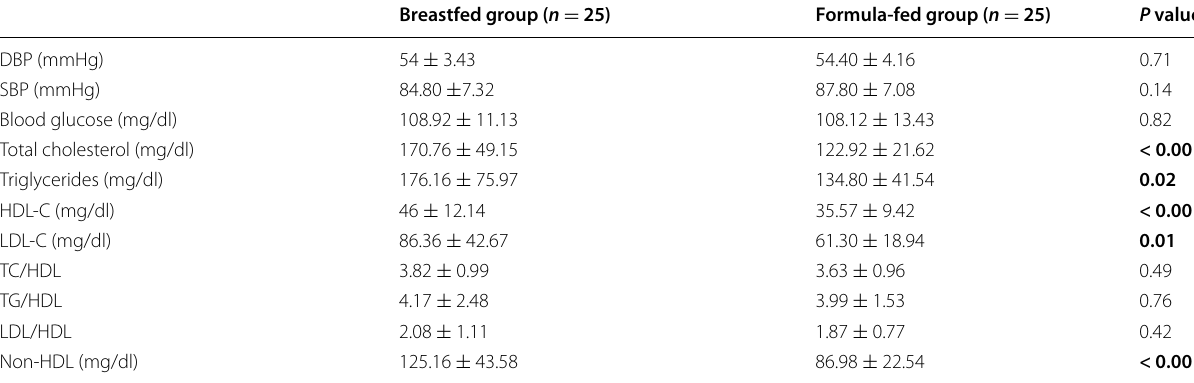
Data expressed mean (SD). Student t‑test was used, and the P value was significant if <